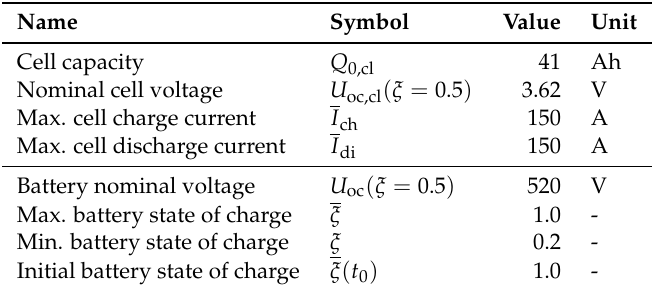
Table 3. Battery pack specs. Battery type: Li-ion.